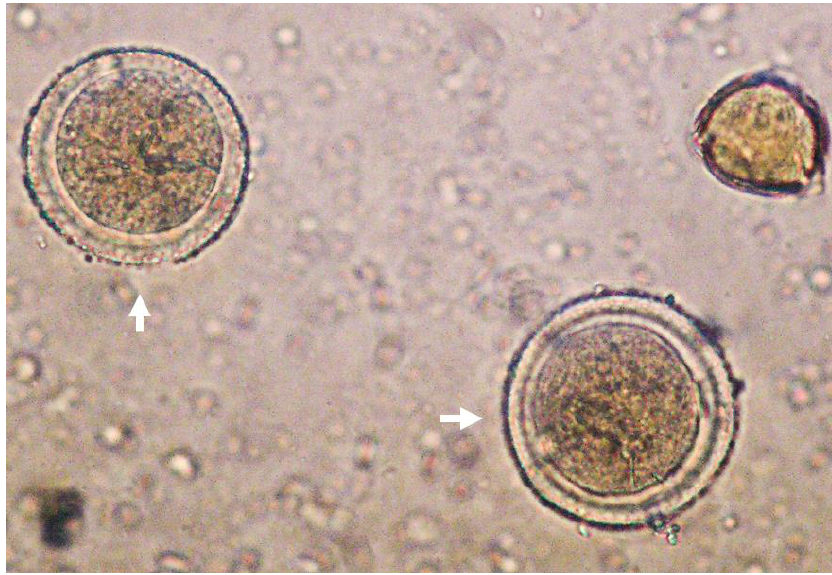
Figure 1. Representative picture of Persea spp. pollen (white arrows) under light microscope (40×).